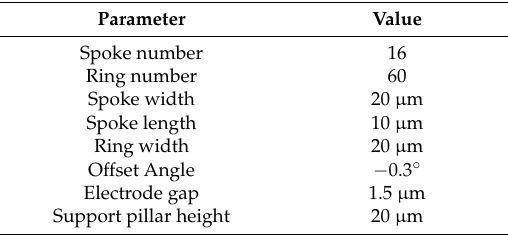
Figure 12. Experimental setup and results: ( a ) Experimental setup for testing the frequency and Q of DRG; ( b ) Comparison of experiment results of DRG with different parameters; and, ( c ) The frequency sweeping data of the selected DRG. Table 3. The Parameters of Selected